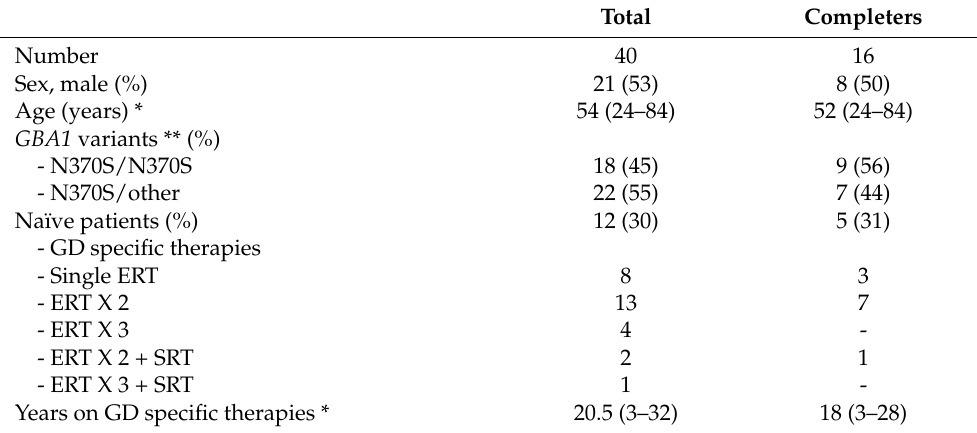
Table 1. Clinical characteristics of patients included in the